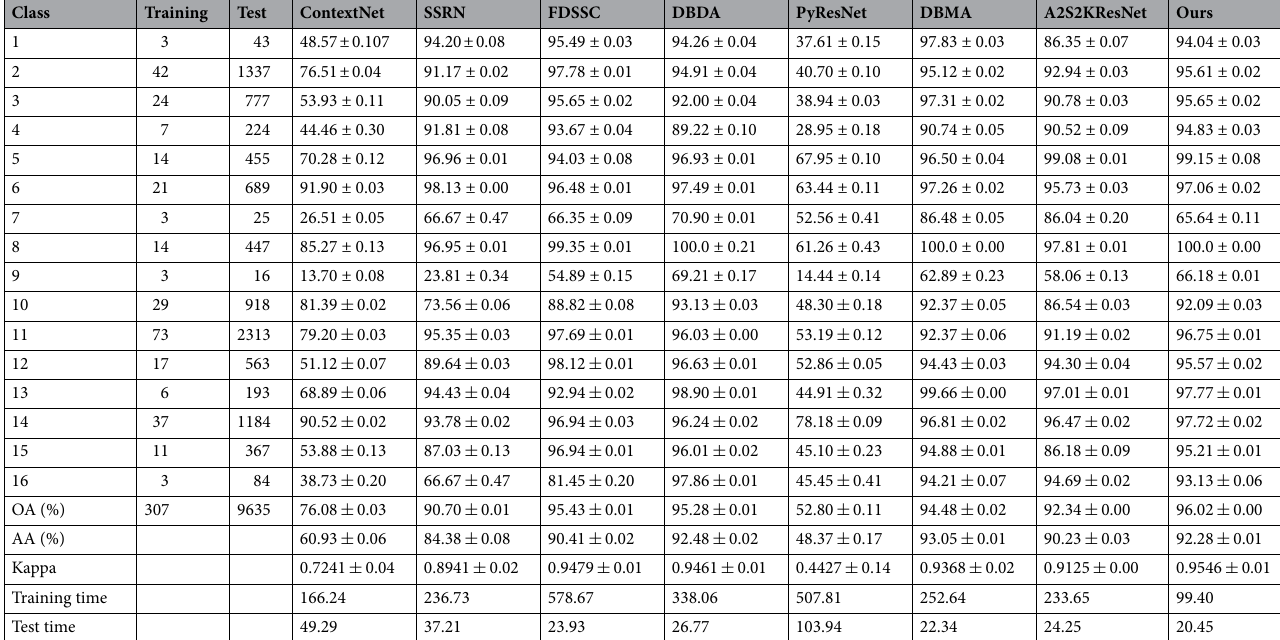
Table 2. The objective indicators on IP dataset (using 3% training, 3% verification, 94% testing).